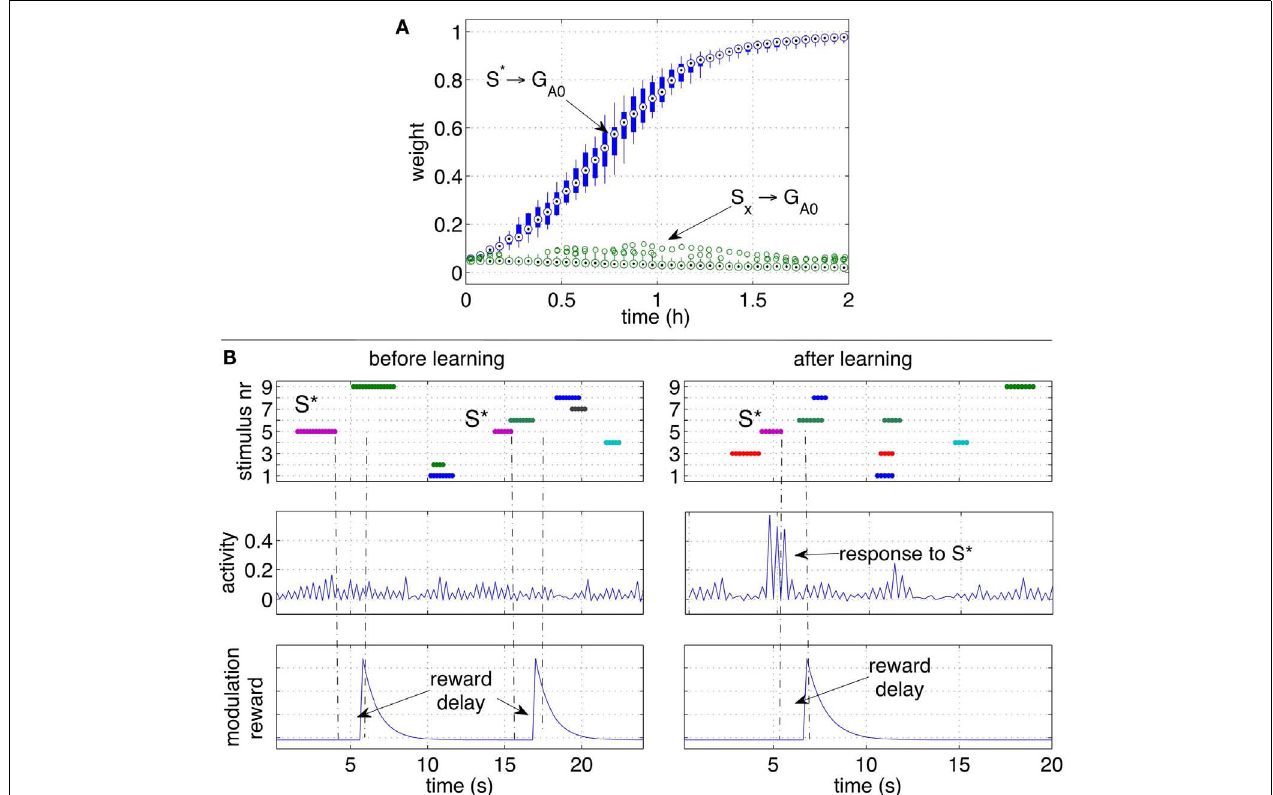
over a brief simulation interval during a particular run.The stimuli (top row), activity of group G A 0 (middle row) and the modulatory signal (bottom row) are plotted before (left) and after (right) learning.While S ∗ does not elicit a response before learning, after learning S ∗ causes a clear increase of the activity of the output group before the reward is